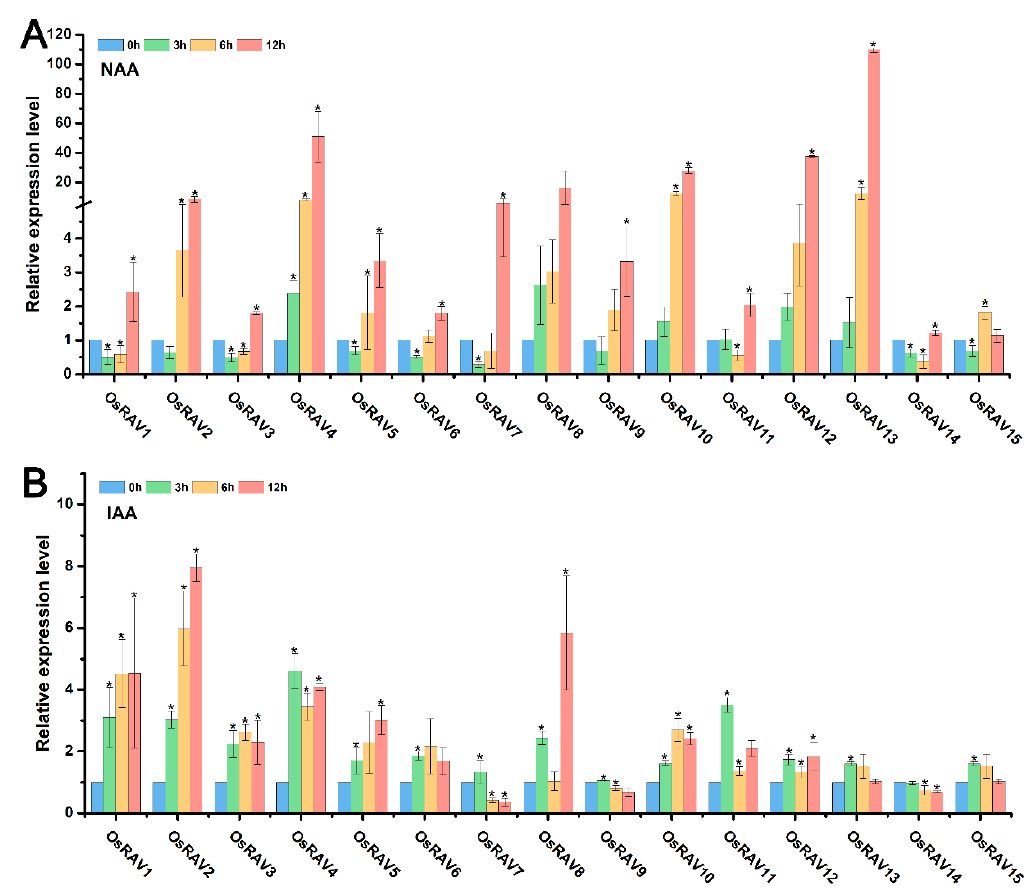
Figure 5. Relative expression level of fifteen RAV genes following hormone treatments. Plants were treated with NAA (50 µ M) ( A ), IAA (50 µ M) ( B ) and sampled at 0, 3, 6, and 12 h. qPCR data were normalized using OsUBQ5 . Results are the means ± standard deviation (SD) of three biological replicates. * indicates significant difference from the mock control at p ≤ 0.05 by Fisher’s least significant difference tests.